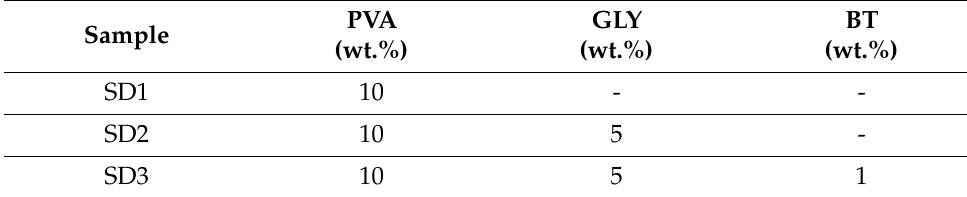
Table 1. Composition of the reference samples.